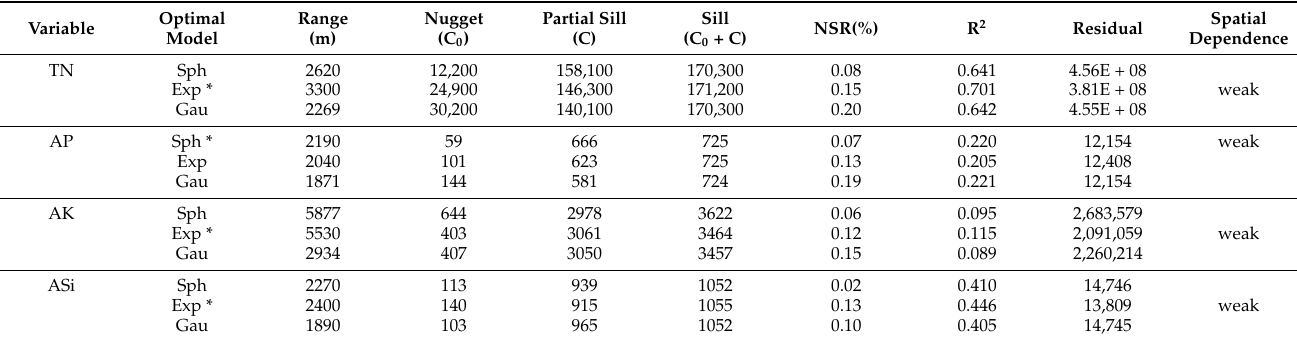
Table 2. Geostatistical analysis of N, P, K and Si in